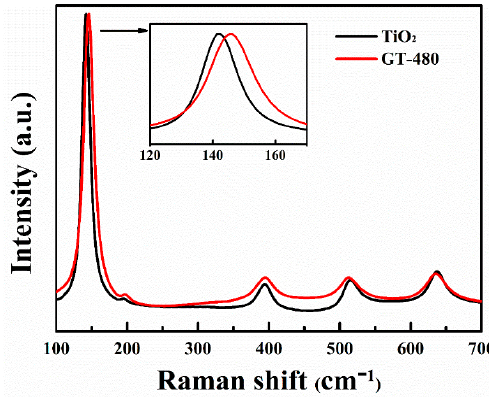
Figure 6. Raman spectra of pristine TiO 2 and gray TiO 2 − x . The inset shows an enlarged view of E g mode of pristine TiO 2 and gray TiO 2 − x .